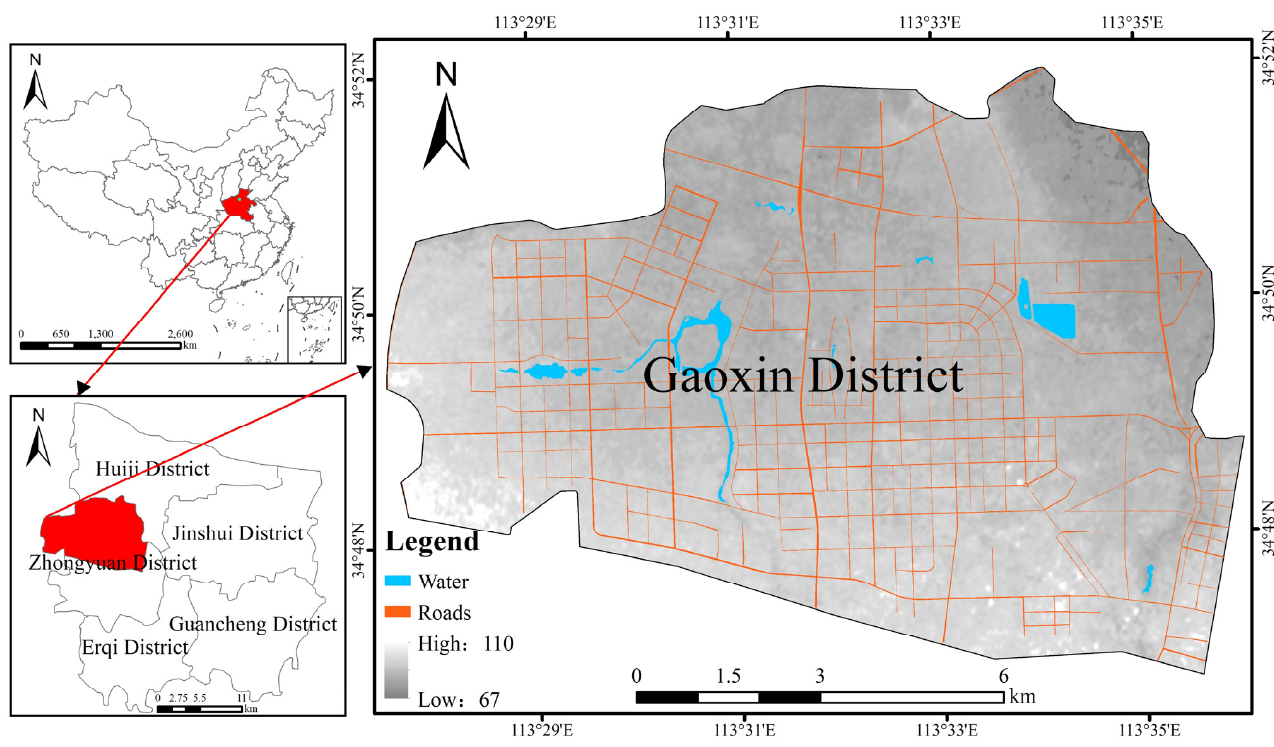
Figure 1. Study area.